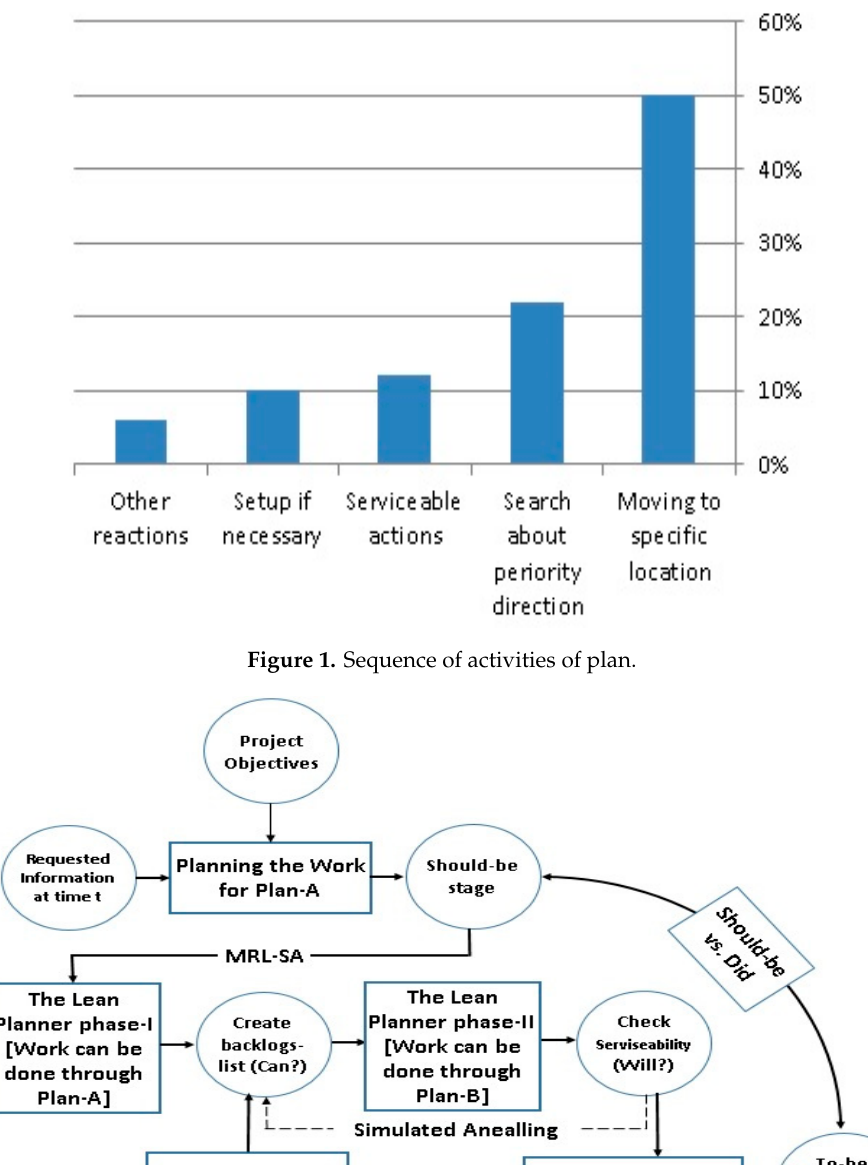
Figure 2. The proposed Lean Planner framework.